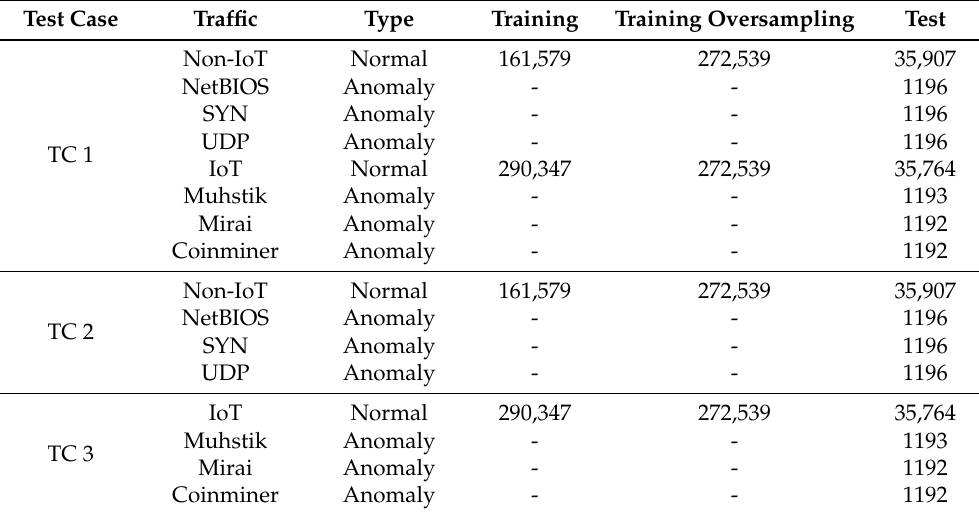
Table 2. Evaluation of the classification models installed on the HSU.